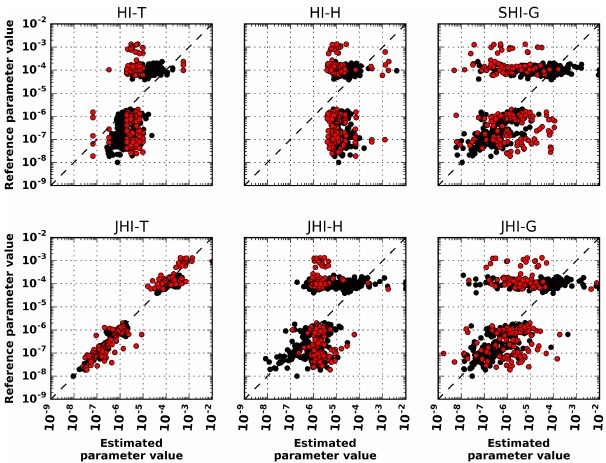
Figure 6. Pilot-point-by-pilot-point scatterplot of reference versus estimated hydraulic conductivity for the six inversion runs. Black dots are estimated parameter values from the capping part of the model, while the red dots are estimated parameter values within the buried